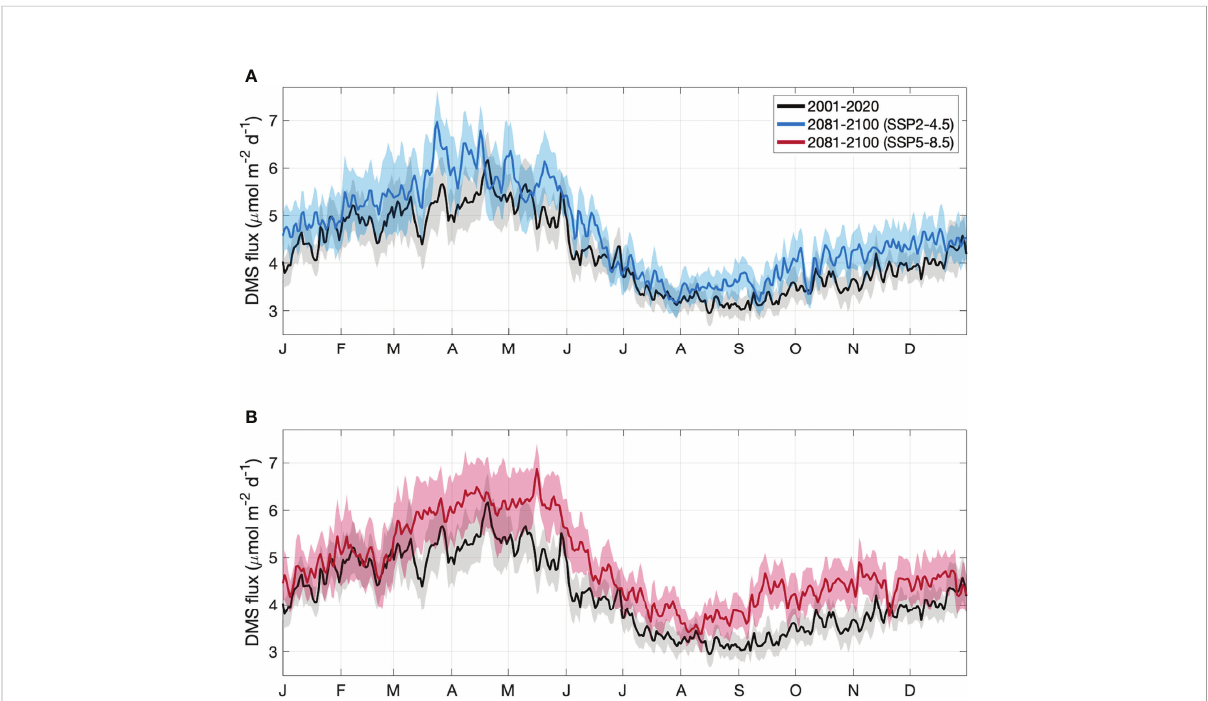
FIGURE 6 Area-averaged climatology of DMS sea-air fl ux in the GBR, derived from CMIP6 contemporary (black) and end of century model output for the (A) SSP2-4.5 (blue) and (B) SSP5-8.5 (red)